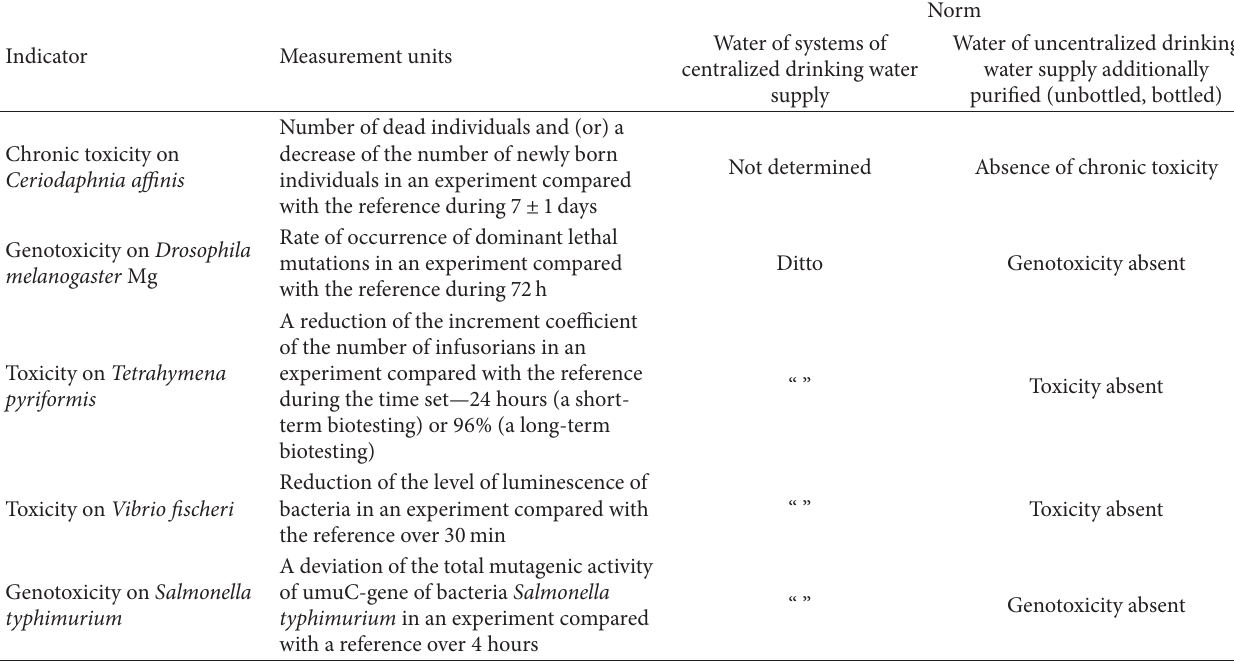
Table 3: Toxicity level of drinking water.